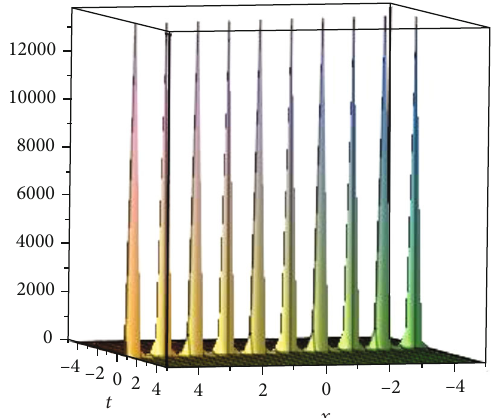
Figure 6: Perspective view of 3D graph of W values ω = 5 , z 0 = − 1/3 , μ = 1 , k = 1 , s = 1 , and e = 1 represents exact solutions.